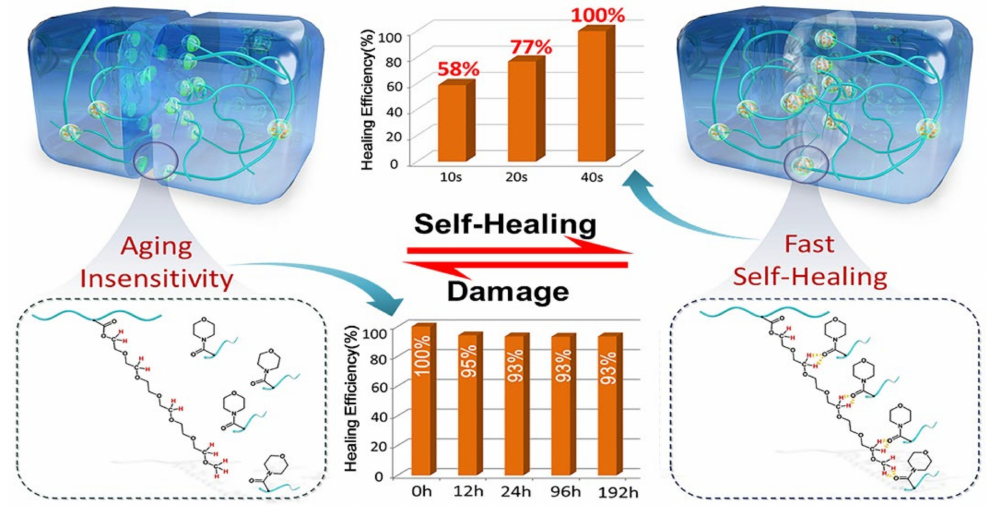
Figure 10. The self-healing properties and the healing mechanism of our fast self-healing elastomers Reproduced with permission from [121]. Copyright 2020 American Chemical Society.